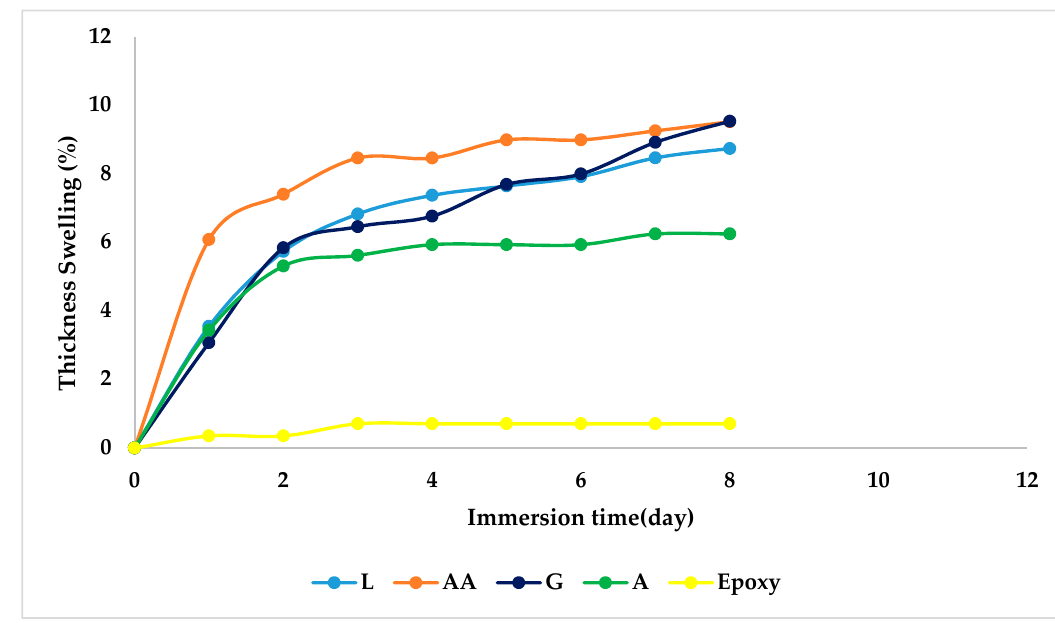
Figure 8. Thickness swelling of DPF/epoxy composites.